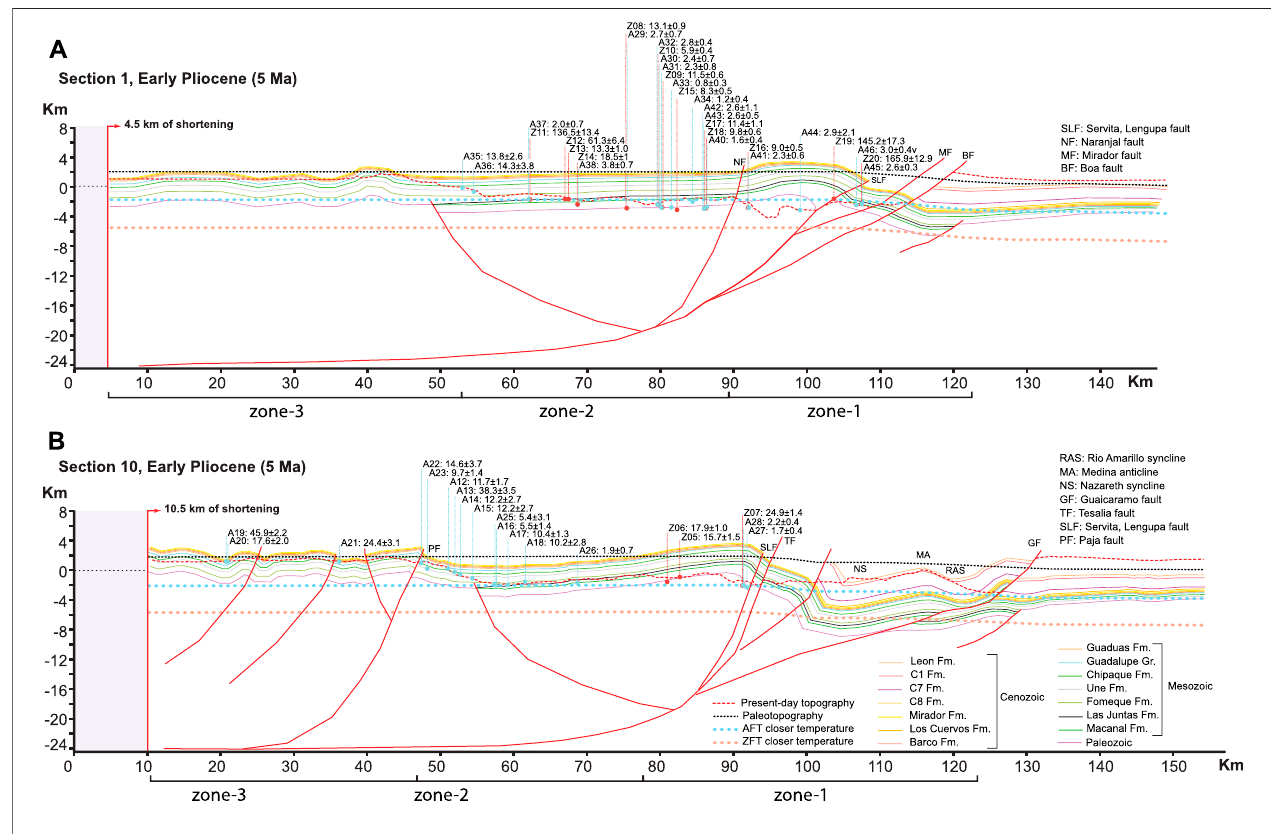
FIGURE 14 | Restoration to ∼ 5 Ma, (A) of Section 1, (B) of Section